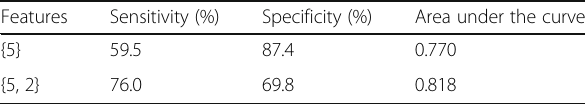
Table 5 Performance of different feature combinations using the linear discriminant analysis